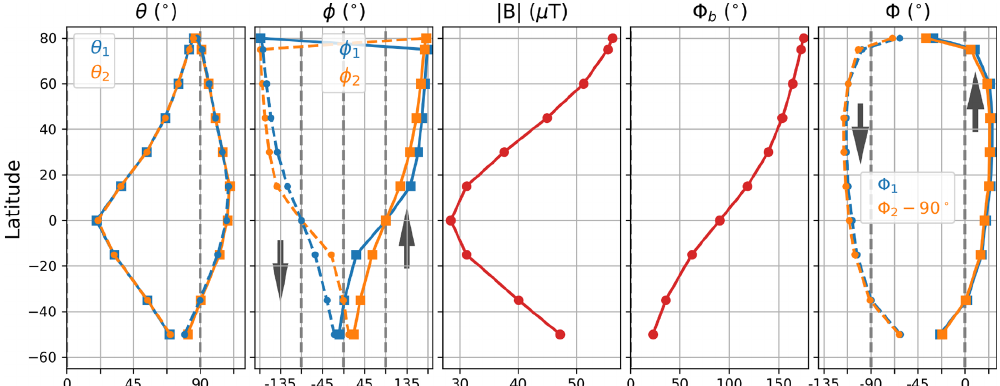
Figure 6. Magnetic field ( θ 1 , 2 , φ 1 , 2 , | B | and (cid:56) b ) and LOS ( (cid:56) 1 , 2 ) parameters (Fig. 4) with respect to latitudes. The blue (yellow) lines are for ANT1 (ANT2) data. The circle–dashed (square–full) lines are data on the descending (ascending) orbit branch. The grey arrows in panels 2 and 5 indicate the direction of the satellite